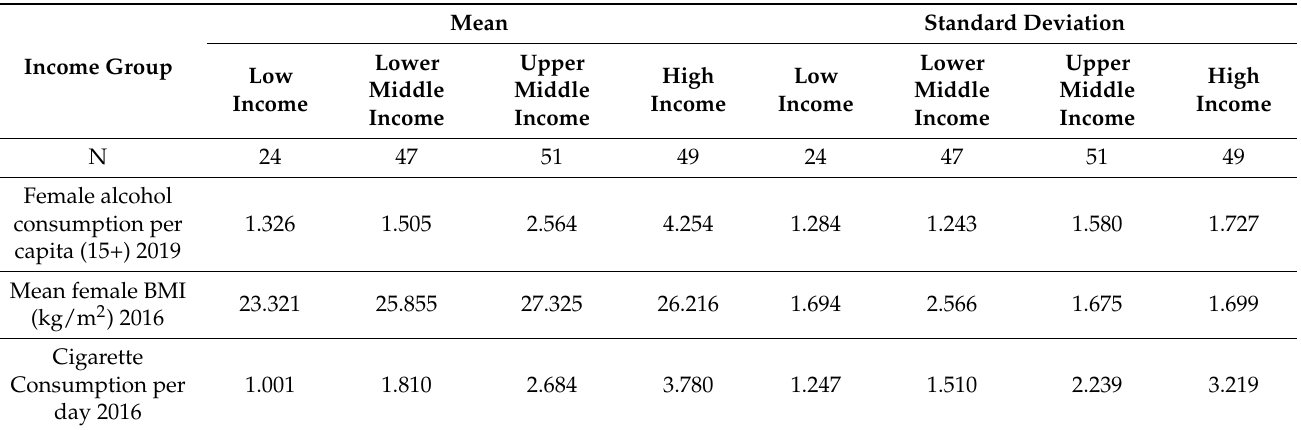
Table 2. Situation of the independent variables grouped by major income